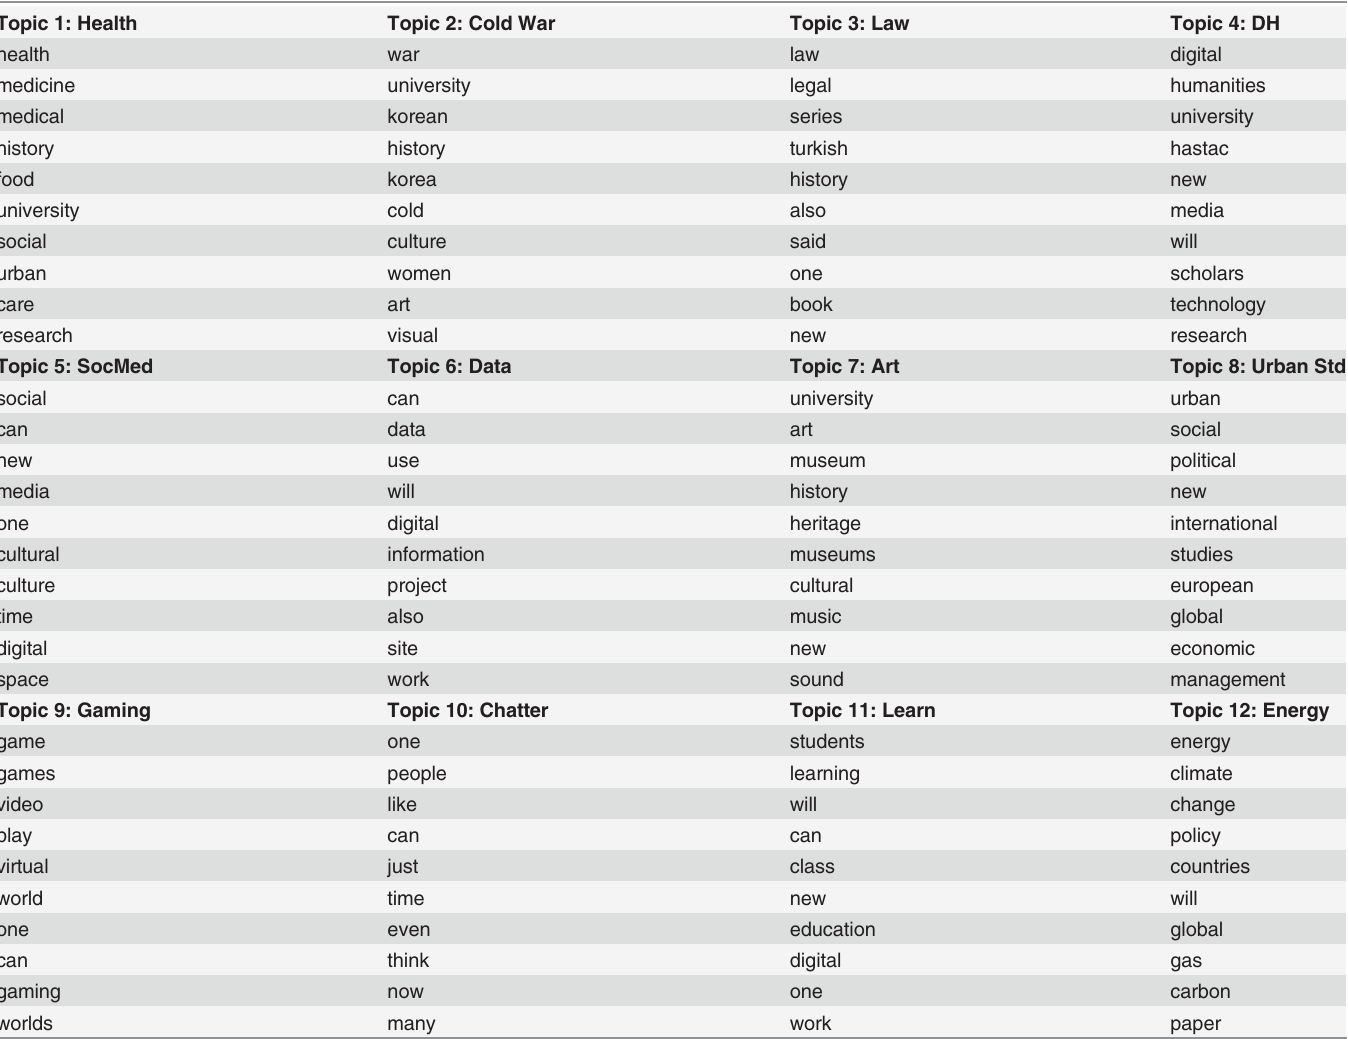
Table 2. Common topics on HASTAC and